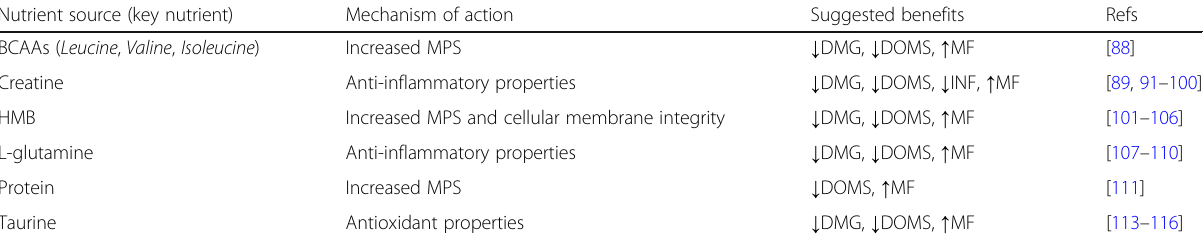
BCAAs branched-chain amino acids, ↓ DMG nutrient reduced indirect markers of muscle damage compared to placebo, ↓ DOMS nutrient reduced soreness and delayed-onset muscle soreness compared to placebo, ↓ INF nutrient reduced markers of inflammation compared to placebo, HMB β -hydroxy- β -methylbutyrate, ↑ MF nutrient improved muscle function relative to